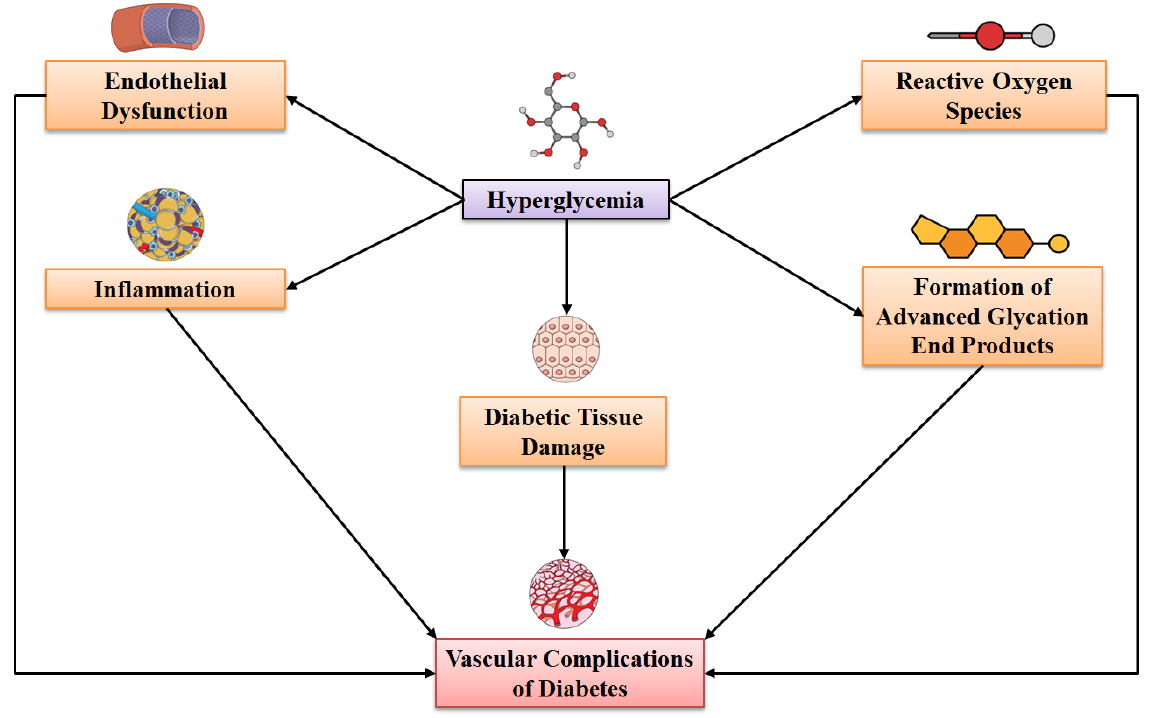
Figure 1. Pathogenic mechanisms that are linked with the development of vascular complications of diabetes mellitus. diabetes